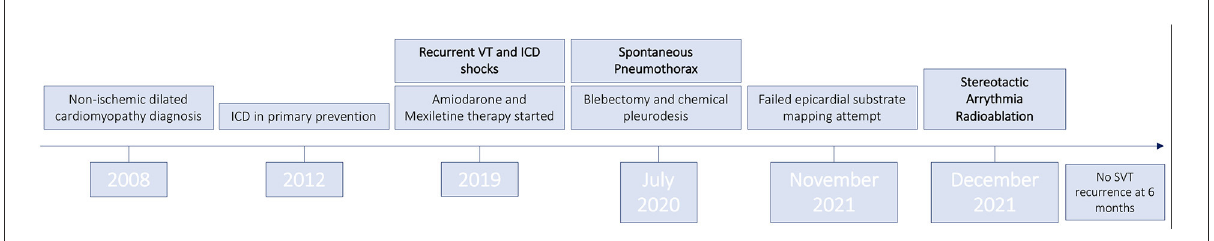
FIGURE1 Patient clinical history